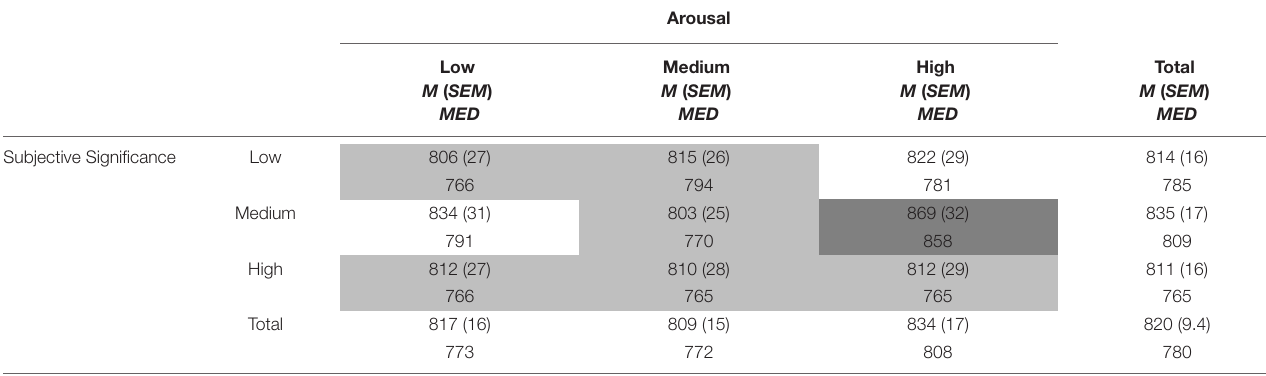
TABLE 3 | Mean and median response times (in ms) for each condition: the shading illustrates the interaction between conditions.